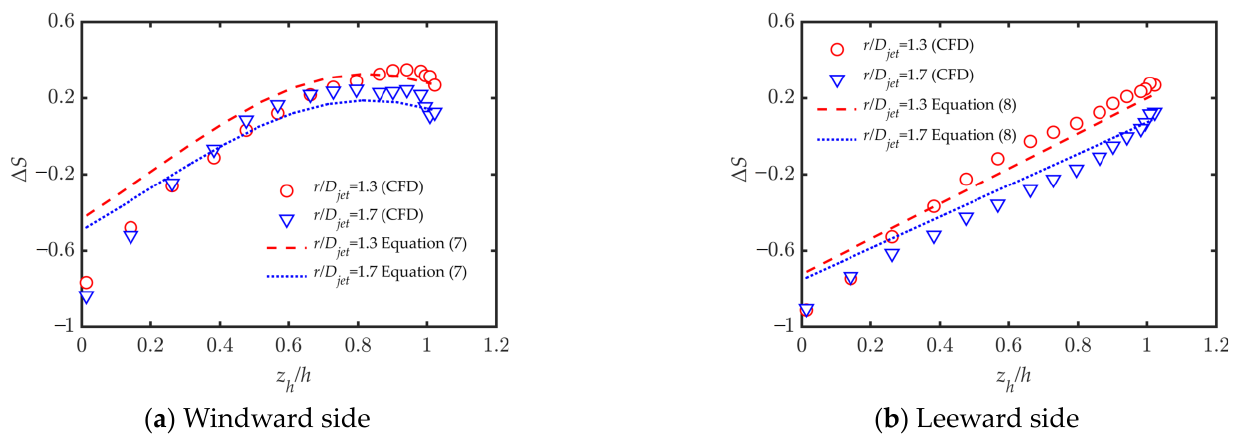
Figure 17. Validation of hill Speedup ratio model for different radial positions.